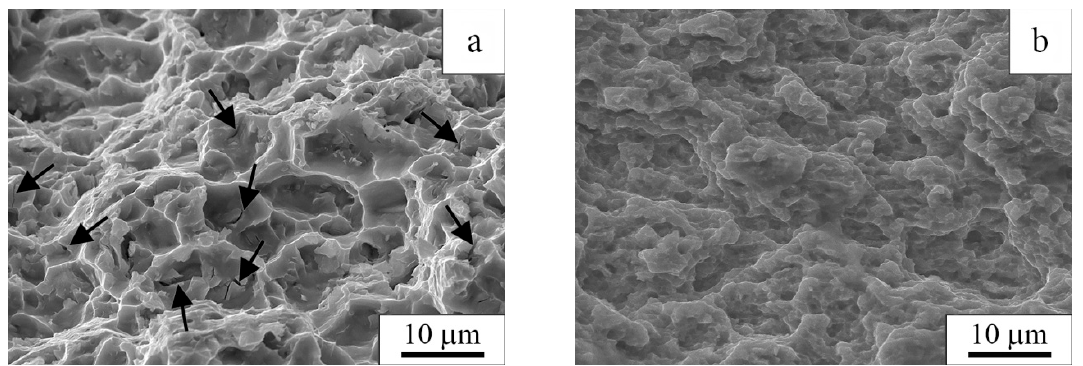
Figure 11. Fracture surface of the Zr–1Nb–0.33H alloy samples after tension at room temperature: ( a ) FG state and ( b ) UFG states.